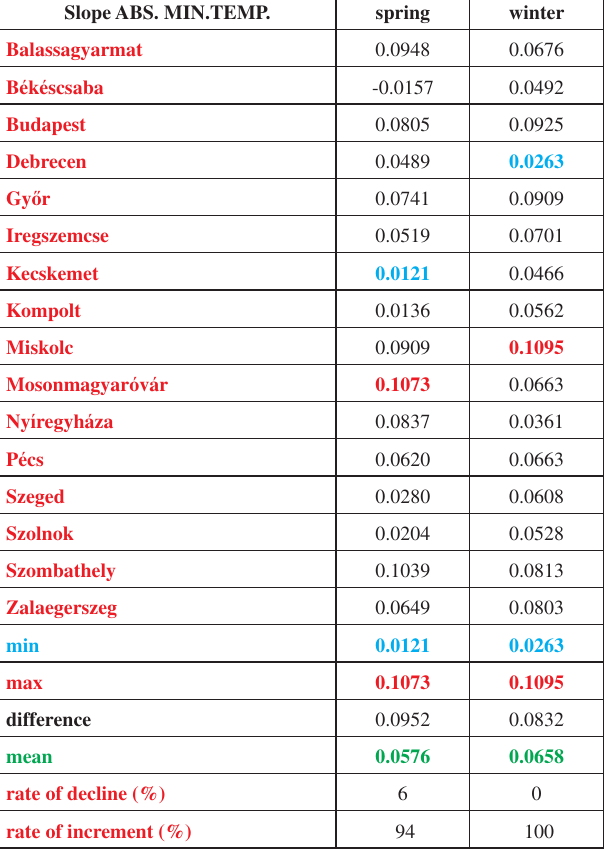
Table 3 – Coeffi cients of correlation between the values of the linear trendfunction and the data of absolute minimum temperatures raised on the 16 stations during spring and during winter (1951–2010) ABS. MIN. TEMP. COEF.